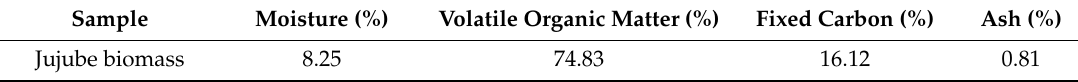
Table 2. Proximate analysis of jujube biomass using the dry